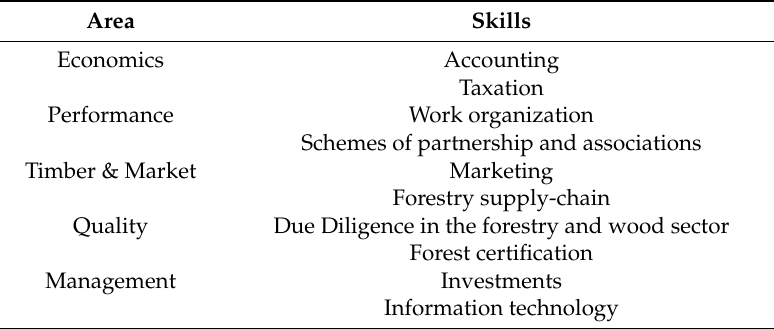
Table 1. Management skills